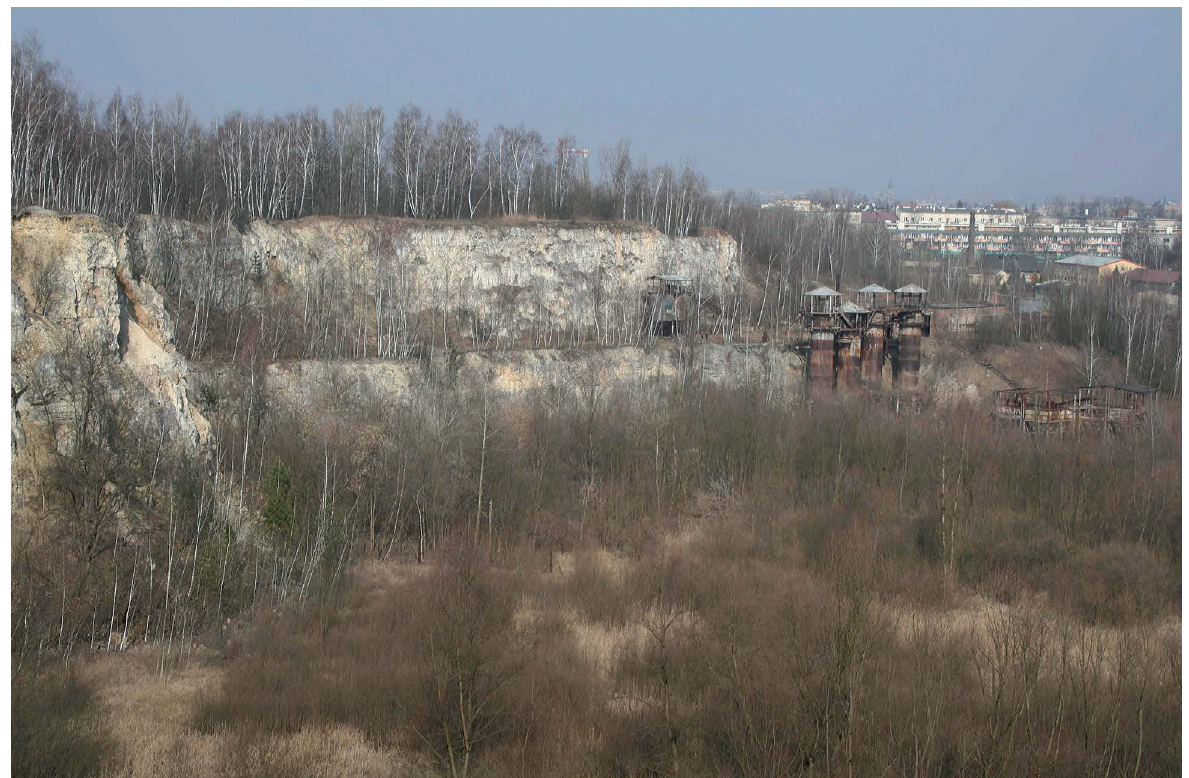
Fig. 5. Renaturalised landscape in the area in the South aspect of “Liban” quarry